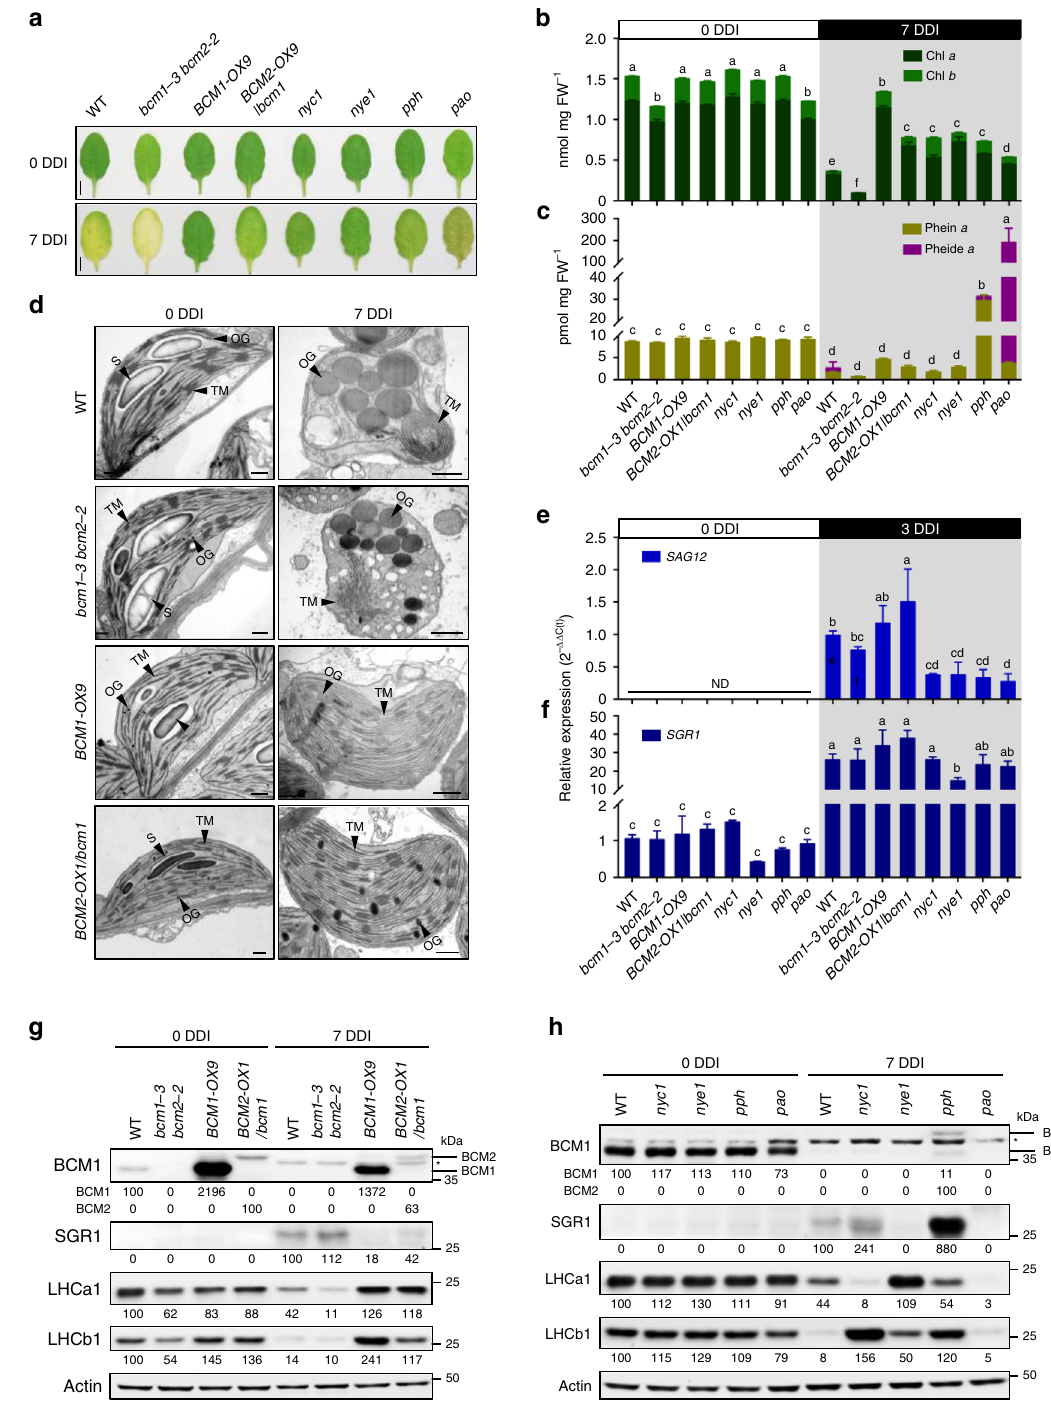
Fig. 6 Both BCMs act as negative regulators of Chl catabolism. a Representative images of detached leaves from 35-day-old Arabidopsis plants grown under short-day normal light (120 μ mol photons m − 2 s − 1 ) conditions prior to (0 DDI) and after 7 days of dark incubation (7 DDI). Scale bars, 0.5 cm. b , c Levels of Chl ( b ) and Chl catabolites ( c ) in the detached leaves shown in a at 0 and 7 DDI. d Transmission electron micrographs showing chloroplast structures at 0 and 7 DDI. OG, osmiophilic plastoglobuli; S, starch granule; TM, thylakoid membrane. Scale bars, 0.5 µ m. e , f qRT-PCR analysis of SAG12 ( g ) and SGR1 ( h ) transcripts in the detached leaves from 21-day-old Arabidopsis plants grown under short-day normal light (120 μ mol photons m − 2 s − 1 ) conditions at 0 and 3 DDI. Expression levels of SGR1 and SAG12 are presented relative to those in the WT seedlings at 0 and 3 DDI, respectively. ND, not detected. g , h Steady-state levels of the indicated proteins in detached leaves from various Arabidopsis seedlings in a at 0 and 7 DDI were detected by immunoblotting using the indicated antibodies. Immunoblot analyses of Actin were used as a loading control. Numbers below the immunoblots represent normalized protein abundances relative to WT seedlings at 0 DDI. Asterisks indicate nonspeci fi c signals on the immunoblots. In b , c , e , f , error bars represent SD of three biological replicates. Letters above histograms indicate signi fi cant differences determined by Tukey ’ s HSD method ( P <